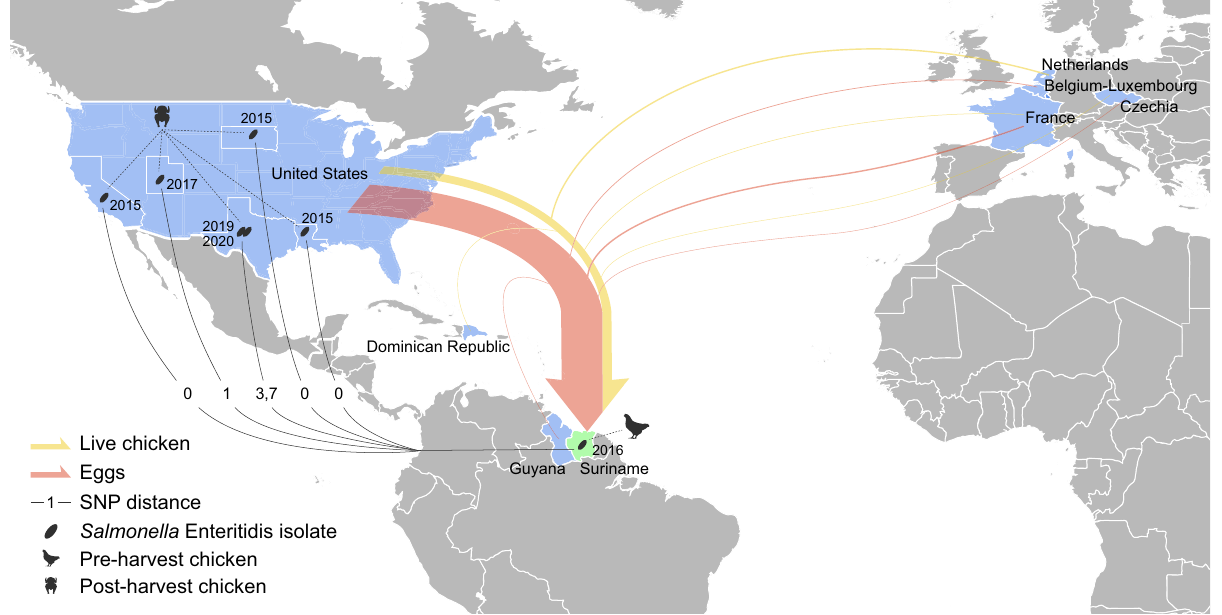
Fig. 2 Closely related poultry Salmonella Enteritidis isolates from Suriname and US and breeding stocks export to Suriname. Arrows indicate the export of live chickens (yellow) and eggs (red) to Suriname. Export data between 2010 and 2016 from the US and other countries were obtained from the US Foreign Agricultural Service (FAS) and the Observatory of Economic Complexity (OEC), respectively. The sizes of arrows are proportional to the monetary values of export. Export of live chicken from the US includes meat-type and egg-type breeding stocks speci fi cally, while that from the other countries includes day-old chicks <185 g. Export of eggs from the US includes only fertilized eggs, while that from the other countries includes shelled, fresh, preserved or cooked eggs. Salmonella Enteritidis isolates are indicated by ovals at the locations of their isolation along with the isolation years. The Suriname isolate was detected in a pre-harvest broiler bird. The US isolates were detected from post-harvest chickens. The numbers on the solid lines indicate pairwise core genome SNP distance between the Suriname isolate and each US